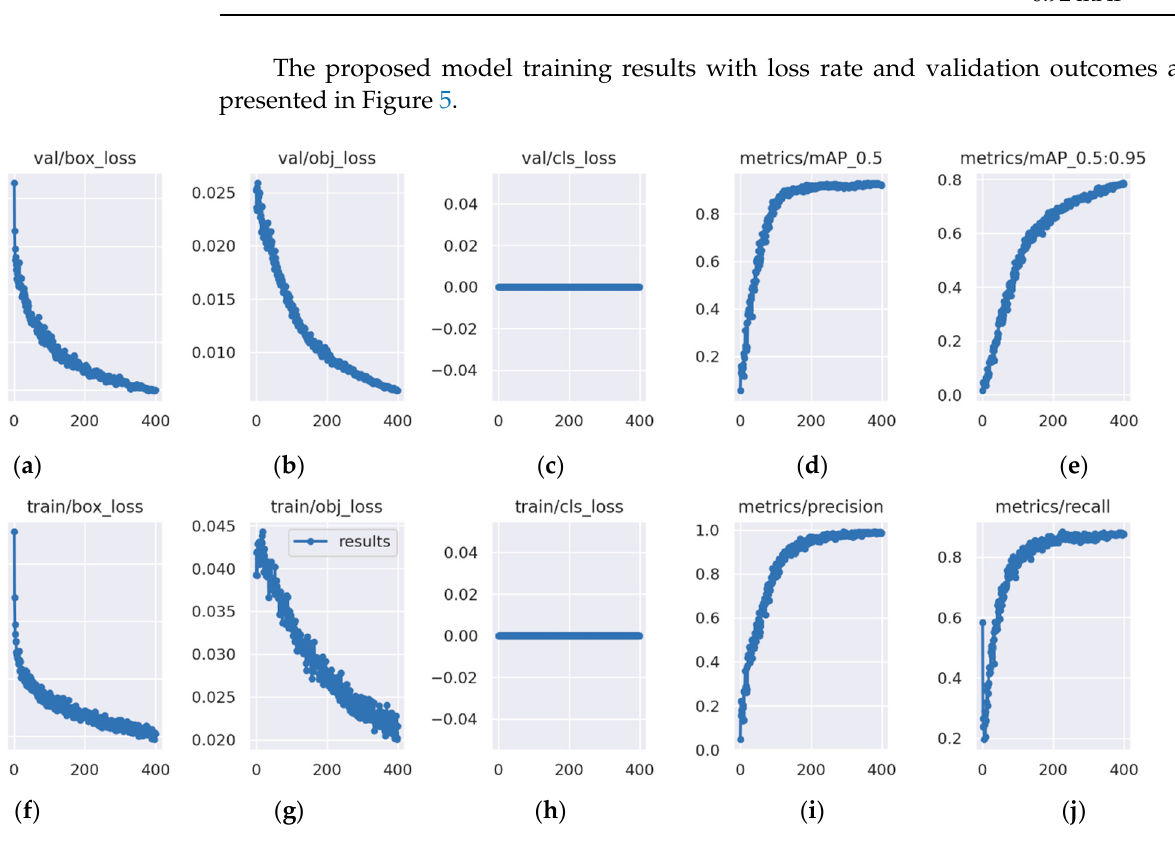
Figure 5. Training/validation results ( a ) loss of training box, ( b ) loss of training object, ( c ) loss of training cls, ( d ) metrics/precision, ( e ) metrics/recall, ( f ) loss of validation box, ( g ) loss of validation object, ( h ) loss of validation cls, ( i ) mAP (0.5), ( j ) mAP (0.95). mAP scores. In Figure 6, the proposed model validation results are visualized.